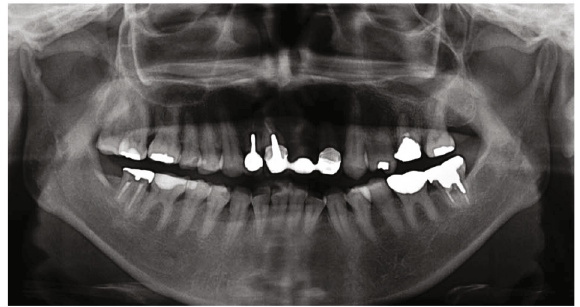
Figure 11: Panoramic radiograph demonstrated the no sign of alveolar bone loss on the transplanted tooth. This patient has maintained all the teeth for almost 30 years from initial